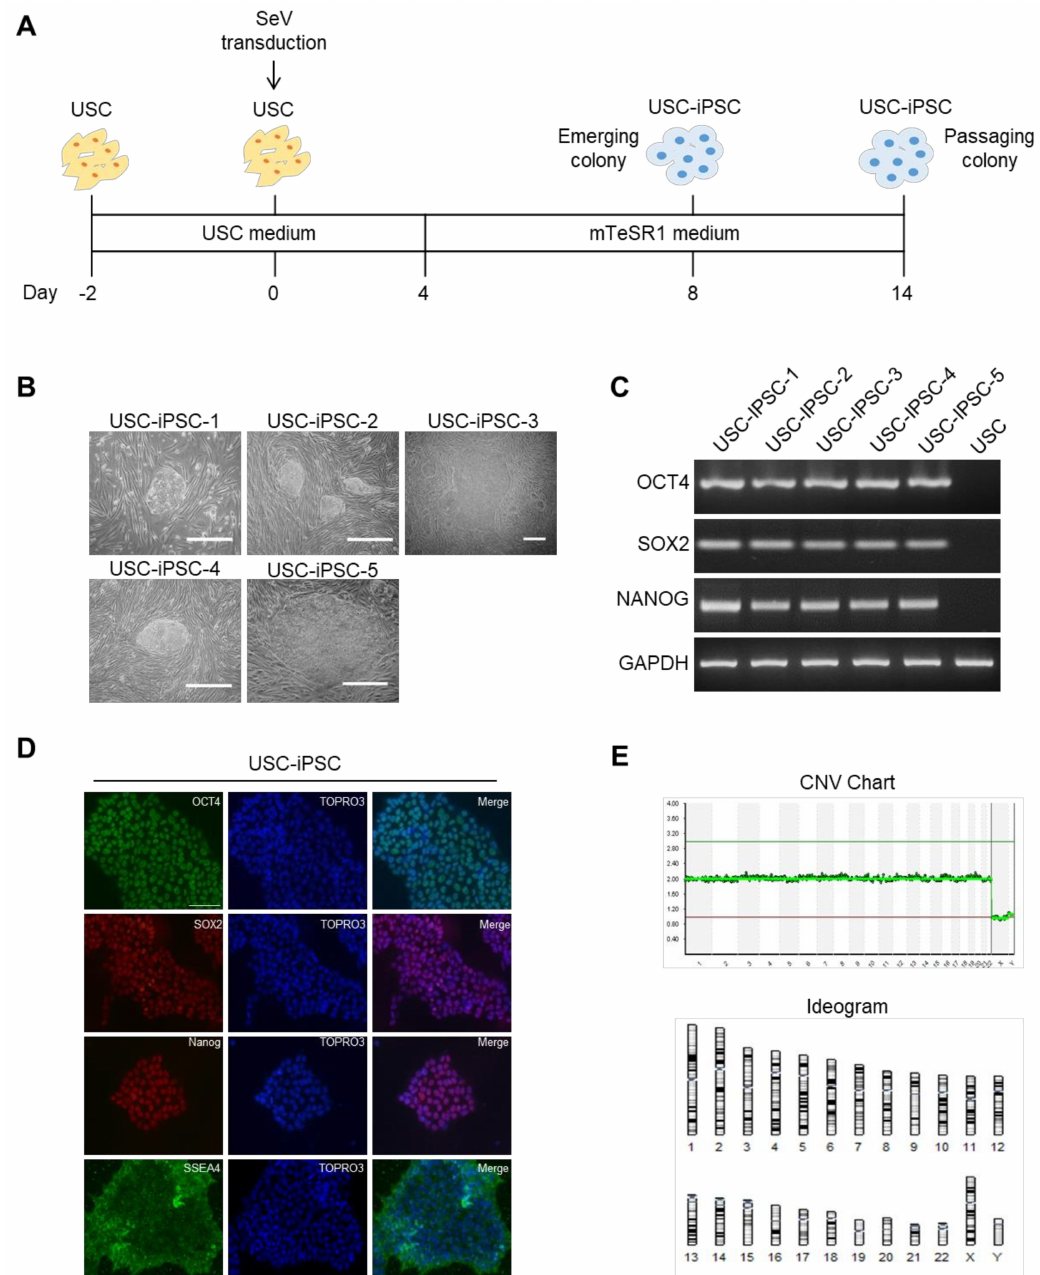
Figure 6. Generation of USC-derived induced pluripotent stem cells (iPSCs). ( A ) Schematic representation of hiPSC generation from USCs using SeV. ( B ) Phase contrast of USC-iPSCs (USC-iPSC-1, 32-year-old male; USC-iPSC-2, 50-year-old male; USC-iPSC-3, 24-year-old male; USC-iPSC-4, 22-year-old female; USC-iPSC-5, 20-year-old male). Scale bar: 200 µ m. ( C ) RT-PCR analysis showing expression of SOX2 , NANOG , and OCT4 in USC-iPSCs. ( D ) Representative immunofluorescence analysis of USC-iPSCs showing the expression of human pluripotent stem cell-specific markers, such as NANOG, SOX2, OCT4, and SSEA4. Scale bar: 40 µ m. ( E ) Single-cell array-based comparative genomic hybridization (aCGH) sequencing for USC-iPSC-1 chromosome abnormalities. ( F ) RNA sequencing of peripheral blood mononuclear cells (PBMCs), USCs, embryonic stem cells (ESCs), USC-iPSCs, and PBMC-iPSCs. Heatmap of hierarchical clustering of differentially expressed genes (DEGs) between of PBMC-iPSCs and USC-iPSCs (Fold change ≥ 2, p -value ≤ 0.05). ( G ) Dendrogram of hierarchical clustering group analysis based on gene expression profiles to show the similarities among the PBMCs, USCs, ESCs, USC-iPSCs, and